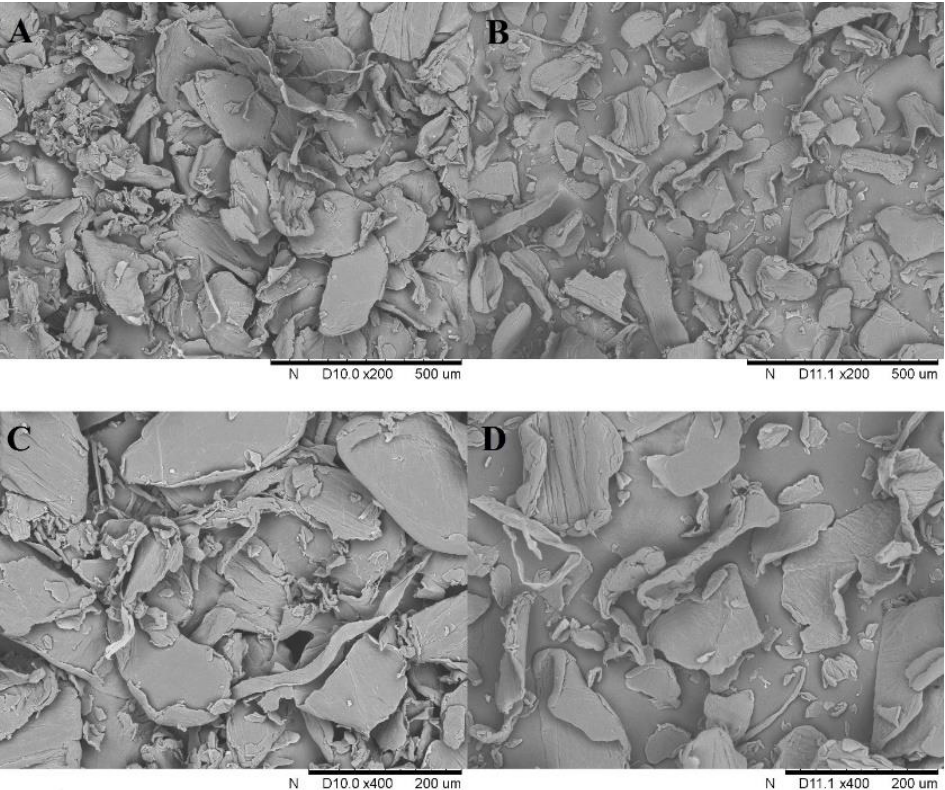
Figure 2. Scanning electron microphotographs of ( A , C ) liquid lipase Novozym 51032 immobilized on chitosan powder ( × 200, × 400) and ( B , D ) chitosan powder ( × 200, × 400).